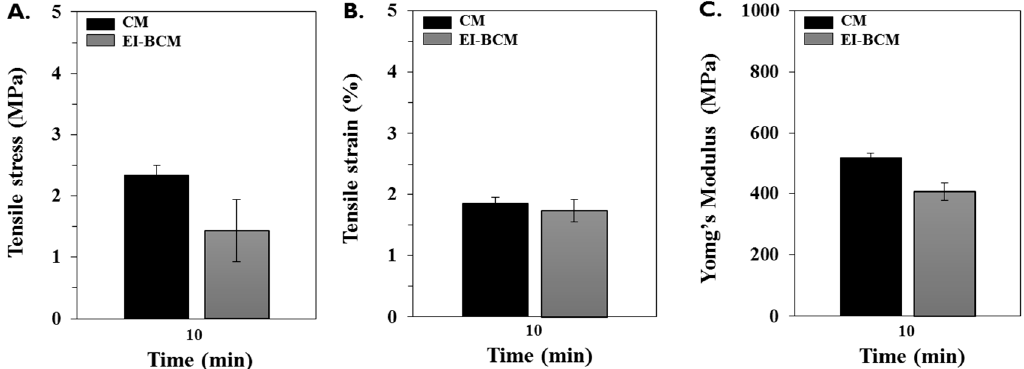
Figure 4. Mechanical properties of the CMs and EI-BCMs after a 10 min soak in water. No significant difference was found between the two membrane types: ( A ) tensile stress (MPa); ( B ) tensile strain (%); and ( C ) Young’s modulus (MPa). The mechanical properties of EI-BCMs were non-significantly different from those of CMs ( p > 0.05).